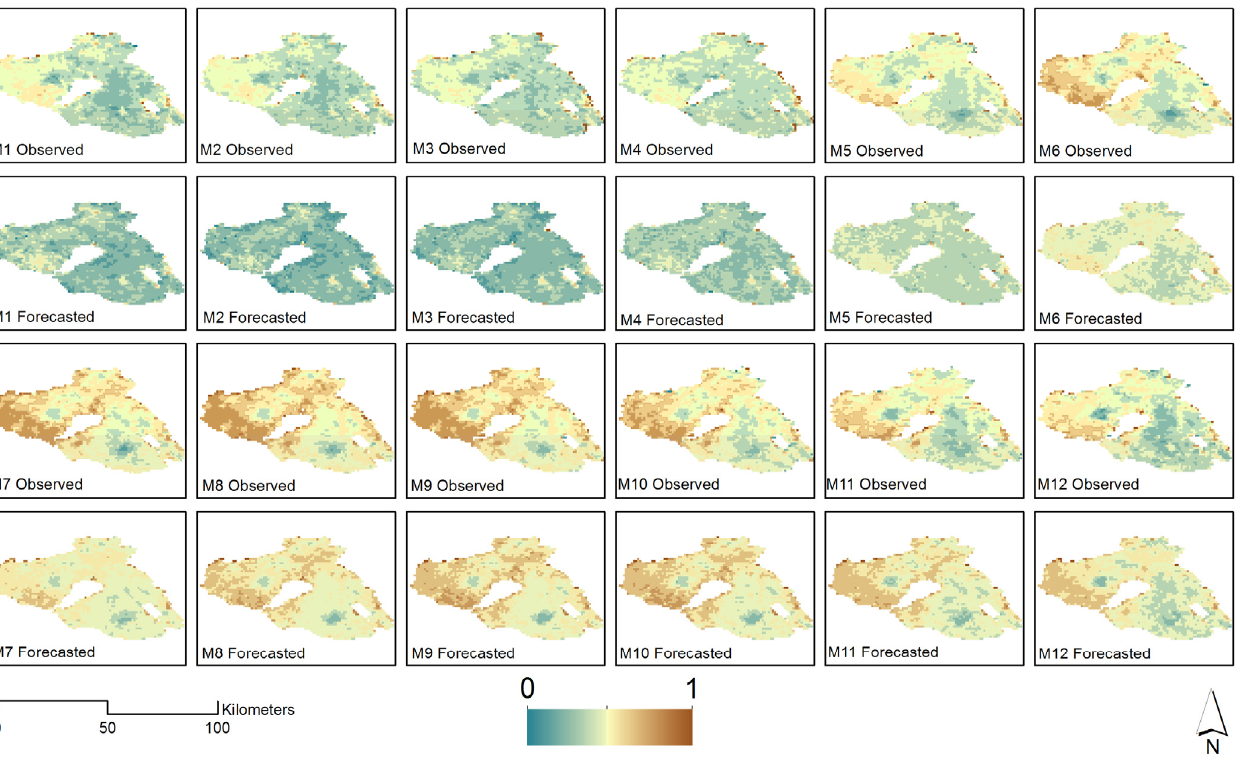
Figure 12. Spatial comparison of observed versus forecasted NDVI of the validation dataset. Symbology of maps is stretched to 0–1.